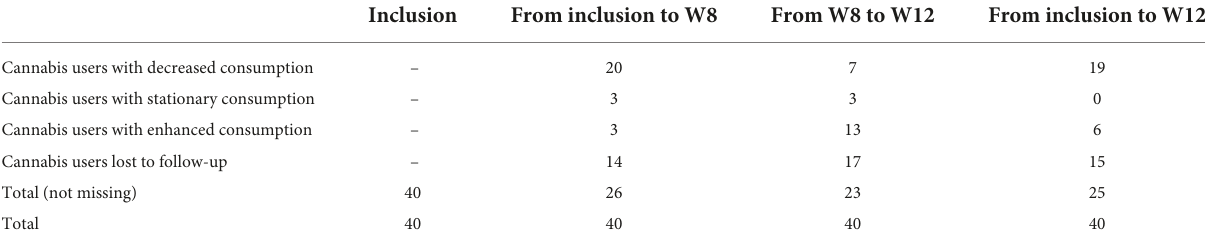
TABLE 3 Number of cannabis users with decreased, enhanced or stationary consumption between W0–W8, W8–W12 and W0–W12.